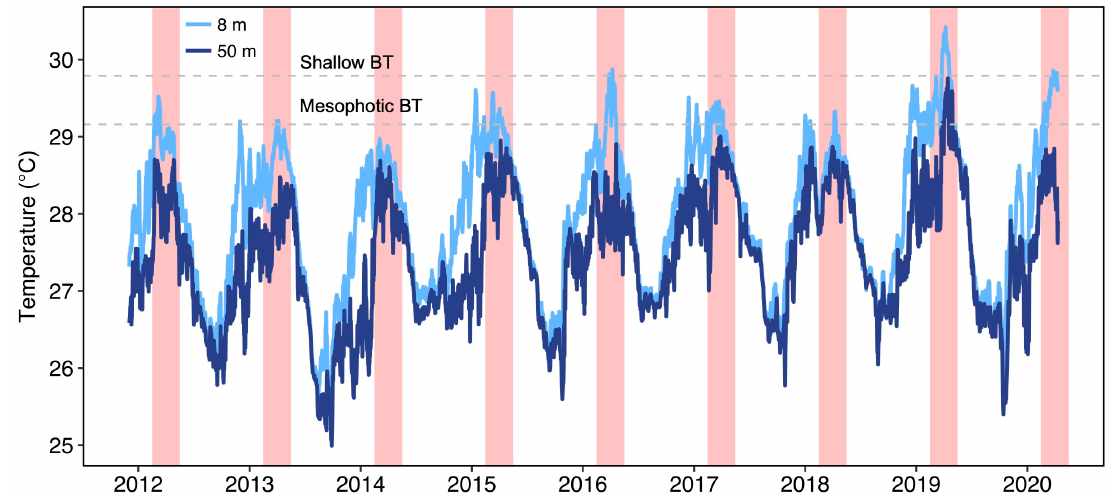
Figure 2. Long-term benthic temperature recordings on the outer reef in Moorea, French Polynesia (17 ◦ 28.870 (cid:48) S, 149 ◦ 53.990 (cid:48) W) contrasted between shallow (8 m) and mesophotic (50 m) depths. Austral summer months (February, March and April) are indicated with red shading. BT = bleaching threshold